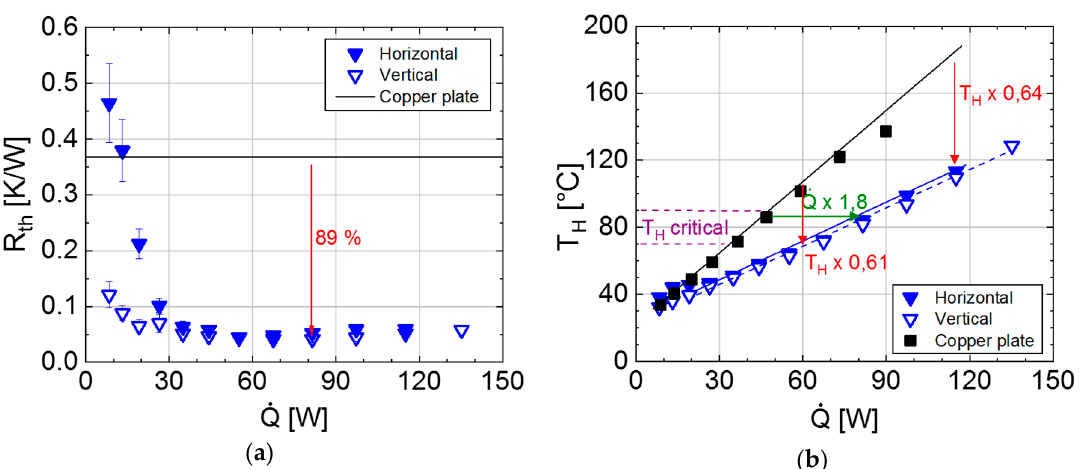
Figure 12. Results for PHPs with channel size of 1 × 1 mm 2 with air cooled heat sink, compared to a solid analogous copper plate. ( a ) Plot of thermal resistance R th vs. heating power ´ Q . Red arrow: reduction in R th compared to copper plate; ( b ) plot of heater temperature T H vs. heating power ´ Q . Results for horizontal and vertical orientation of the PHP with respect to gravity are given. Red arrow: heater temperature of heater on PHP relative to copper plate at the same heating power. Green arrow: heating power of heater on PHP relative to copper plate at the same temperature.